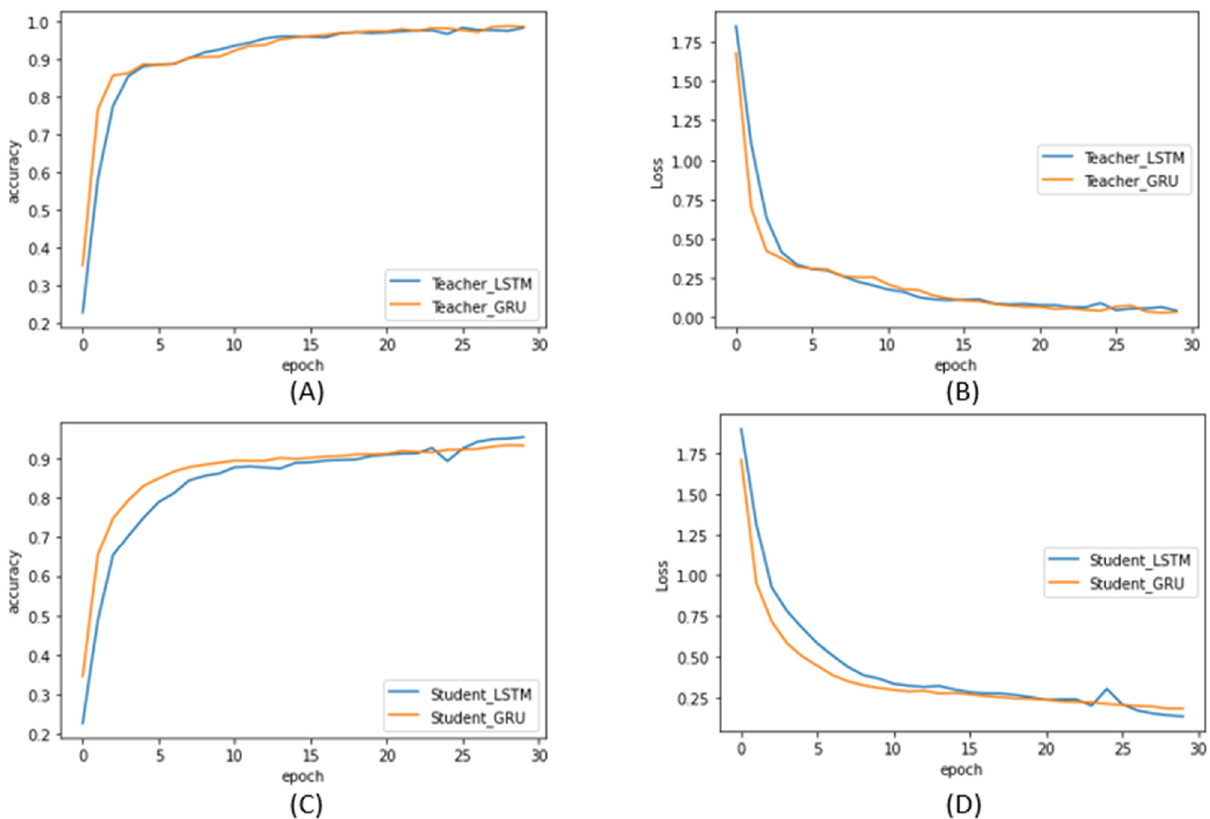
Figure 6. Accuracy and loss graphs of LSTM and GRU models for teacher and student models: ( A )